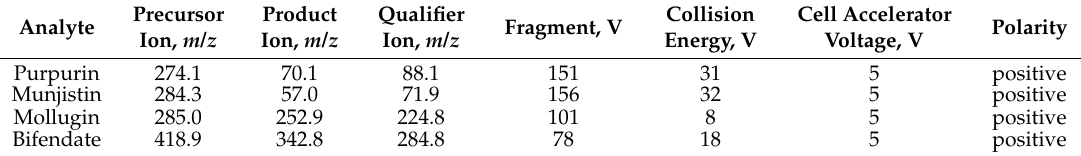
Table 1. Optimized mass spectrometric parameters for the LC/MS analysis of purpurin, munjistin, mollugin and bifendate in MRM